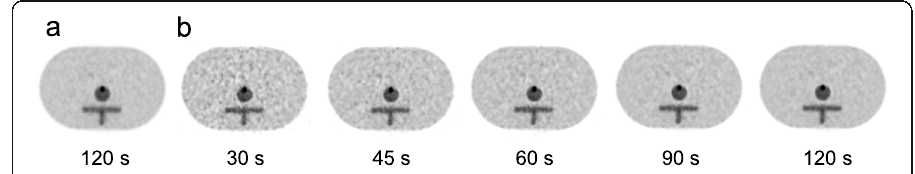
Fig. 2 Sample PET images acquired from a 13-mm sphere with different acquisition durations and reconstructed using OSEM (2 iterations) ( a ) and BPL ( β value, 400) ( b